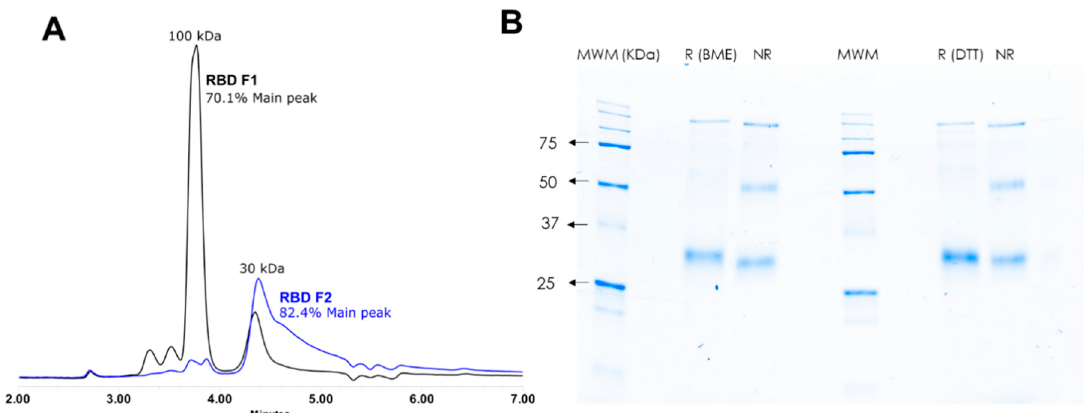
Figure 1. Characterization of the RBD protein. The RBD protein was expressed in HEK 293 cell cultures and purified on a HisTrap™ Nickel column; two fractions were obtained. ( A ) Native SEC analysis evinced that Fraction 1 (RBD F1; black line) was mainly composed of a ~100 kDa protein and Fraction 2 (RBD F2; blue line) by a ~30 kDa protein, which may correspond to the trimer and monomer of the RBD protein, respectively. ( B ) Fraction 2 also exhibits the main band at ~30 kDa when analyzed in denaturing SDS-PAGE using two reducing agents (BME and DTT). Fraction 2 was used for the rest of the work.